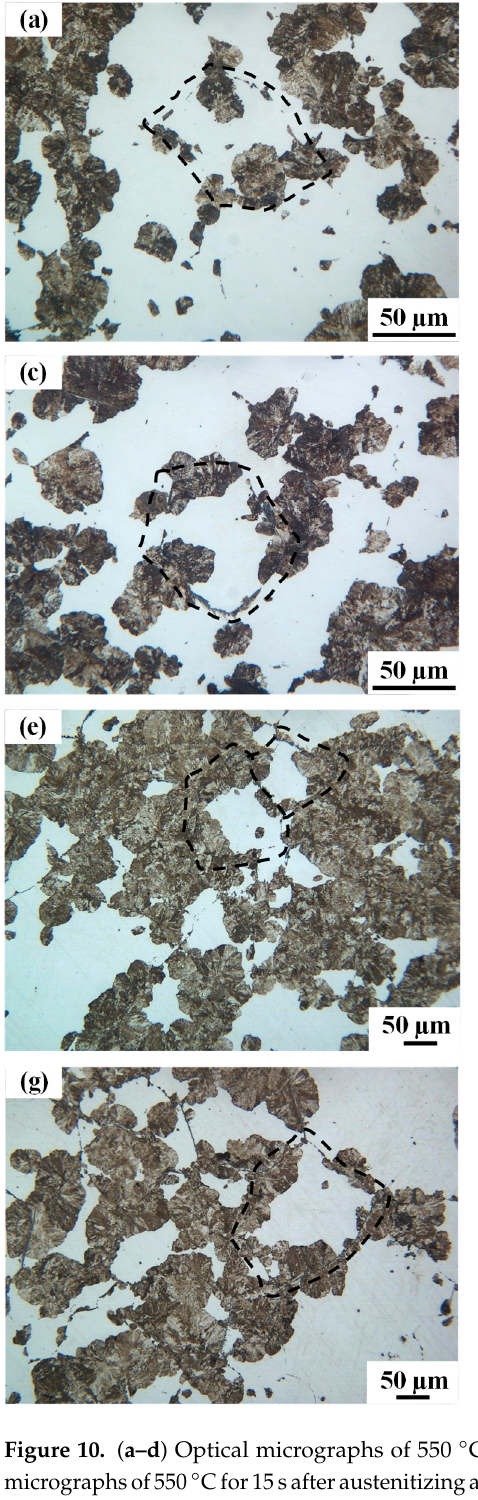
Figure 9. SEM microscopy of isothermal austenite/pearlite transformation at 550 °C for 10 s after austenitizing at 880 °C; ( b ) an enlarged view of the black circle in ( a ).